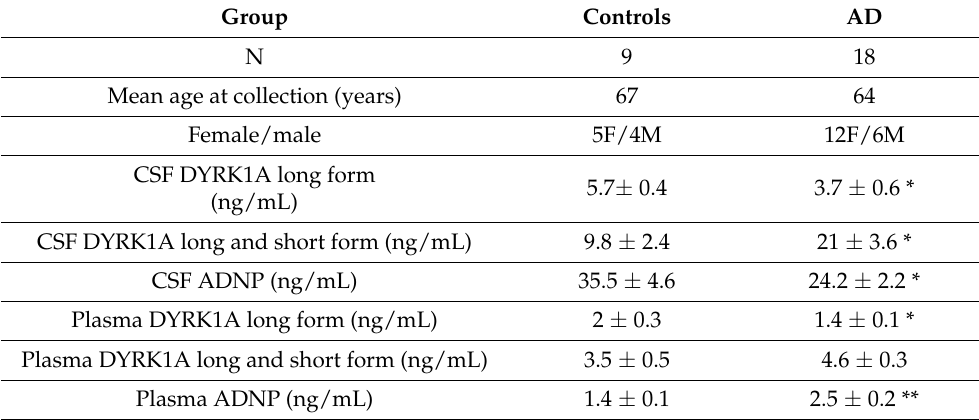
Table 2. Demographics and biomarker data of participants with AD and controls. Group Controls